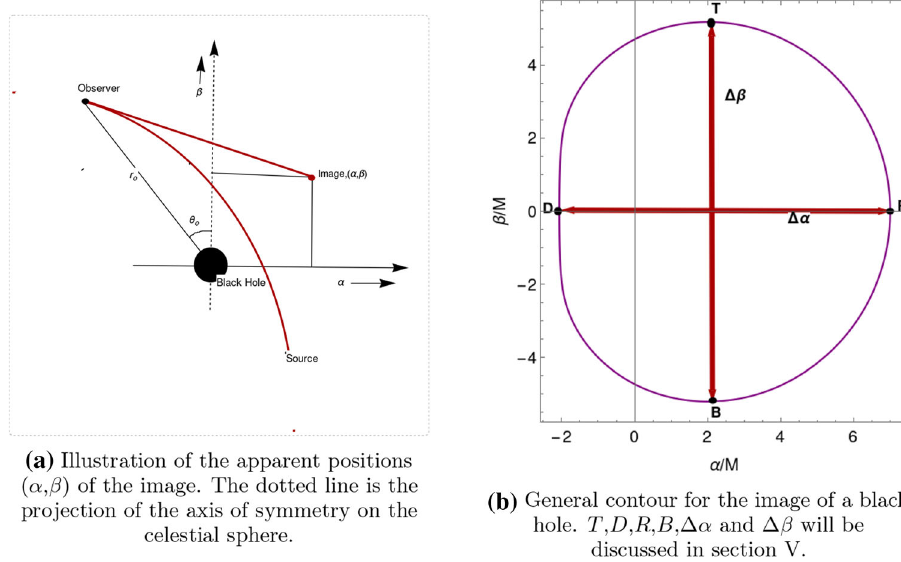
Fig. 1 Illustration of